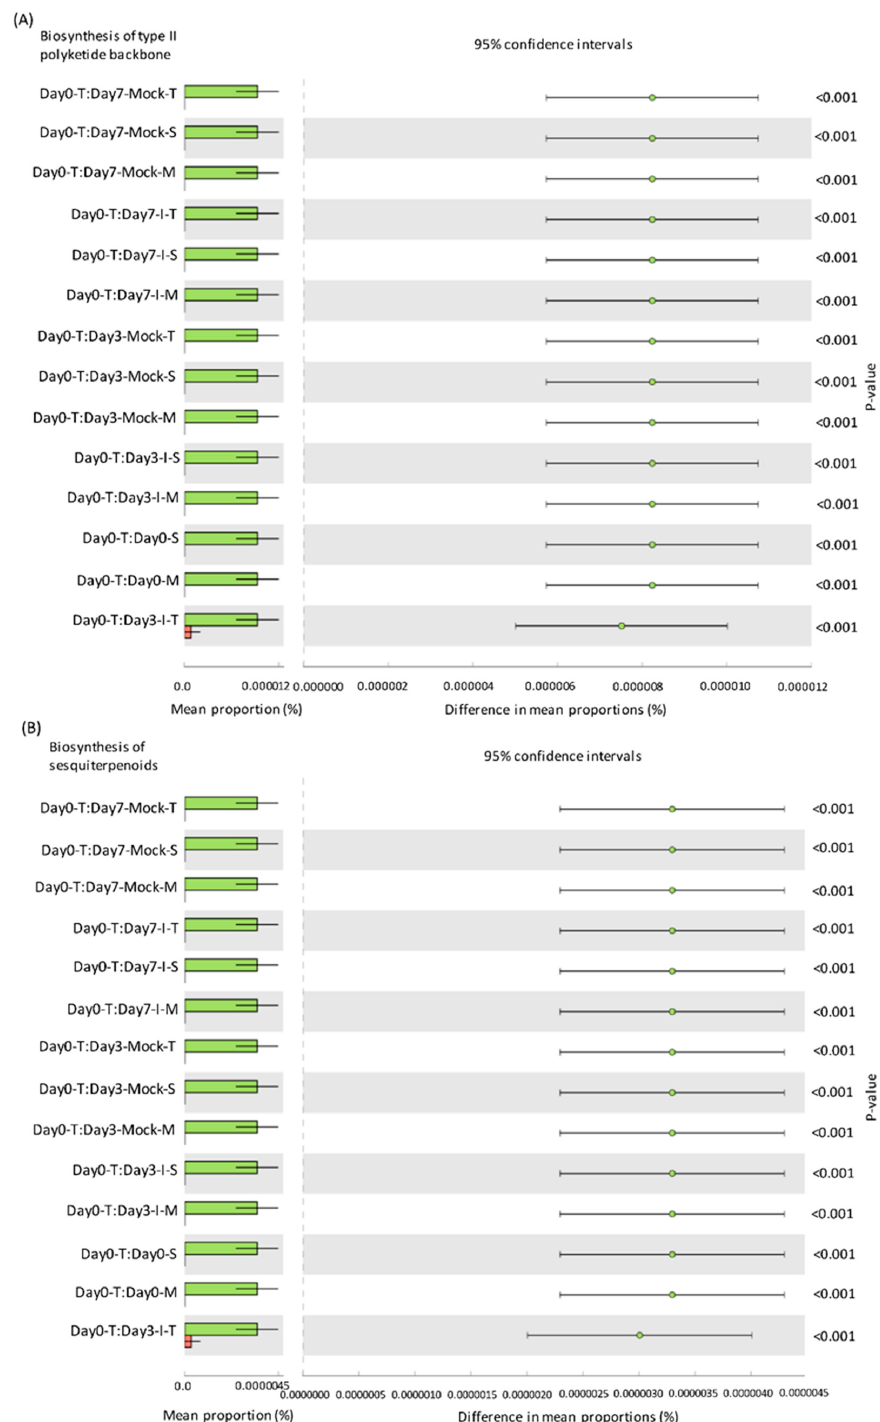
Figure 5. Kyoto Encyclopedia of Genes and Genomes (KEGG) modules found to be significantly different ( p < 0.05) between treatment groups after Bonferroni test correction: ( A ) biosynthesis of the type II polyketide backbone and ( B ) sesquiterpenoid biosynthesis. Note: The expression of each KEGG module is significantly reduced between Day0-T (Green) and all other treatment groups. S: SC212, susceptible genotype; T: TZAR102, resistant genotype; M: MI82, resistant genotype. Mock = mock control and I = A . flavus -infected. The data are mean ± SE of 3 replicates, and each replicate consists of four